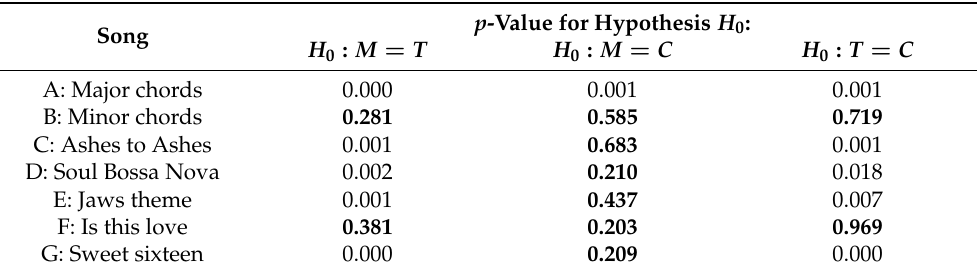
Figure 9. Results of Experiment 2 with Pump-and-Vibe. Distributions of the adjectives given by participants in response to the stimuli according to Hevner’s adjective circle. The 3 adjectives each participant chose per stimulus were categorised by group (1–8) and the circular mean taken. Polar plots (1–7) for each song show one standard deviation around the mean of all participant adjective responses to each song for music only (M1–M7), tactile only (T1–T7) and combined presentations (C1–C7). The categories 1–8 are presented in the corresponding location on the circumplex plane as illustrated in the bottom- right panel. * For song 7 the tactile element T7 was randomly generated and not mapped from M7. Table 3. Results of a parametric Watson–Williams multi-sample test for equal means to compare stimuli types music (M), tactile (T) and combined (C) across participants for the 7 songs shown in Figure 9. Reject H 0 for small p values; results in bold indicate H 0